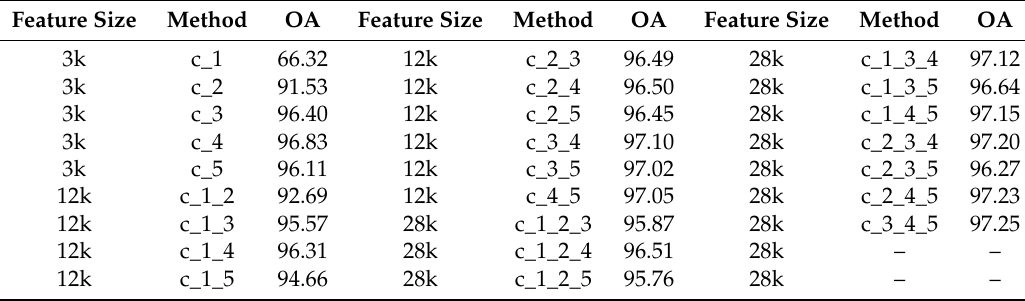
Table 1. Classification accuracy of different convolutional layers